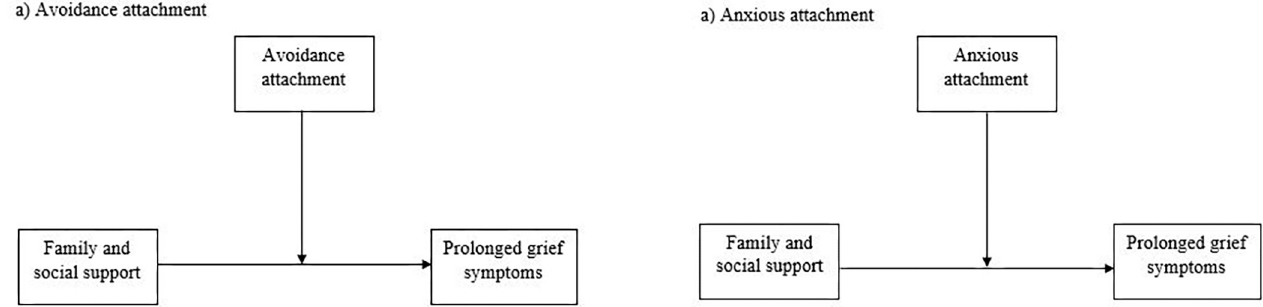
Fig 1. Conceptual model of the moderated role of Avoidance (a) and Anxious (b) attachment factors in the relationship between family/social support and prolonged grief symptoms.